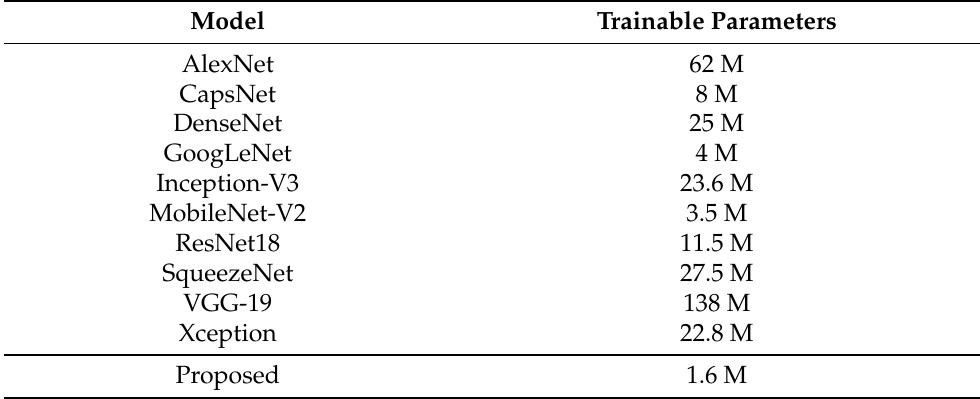
Table 13. Number of trainable parameters of the most common deep models (in